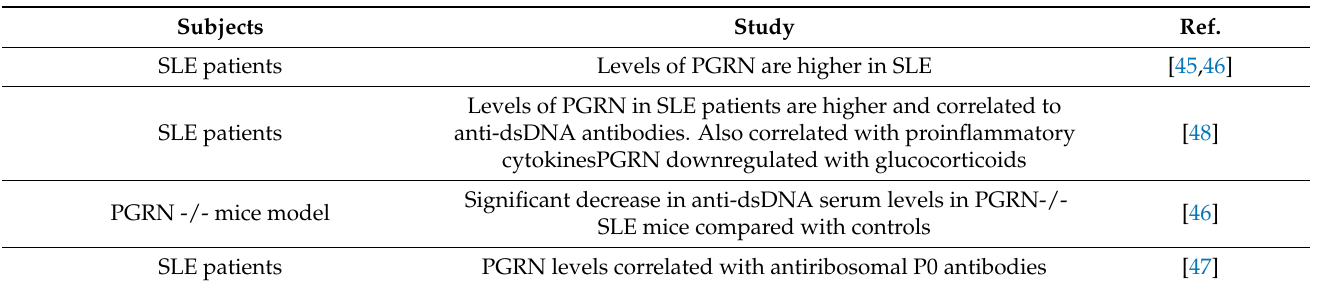
Table 2. Main findings related to PGRN in